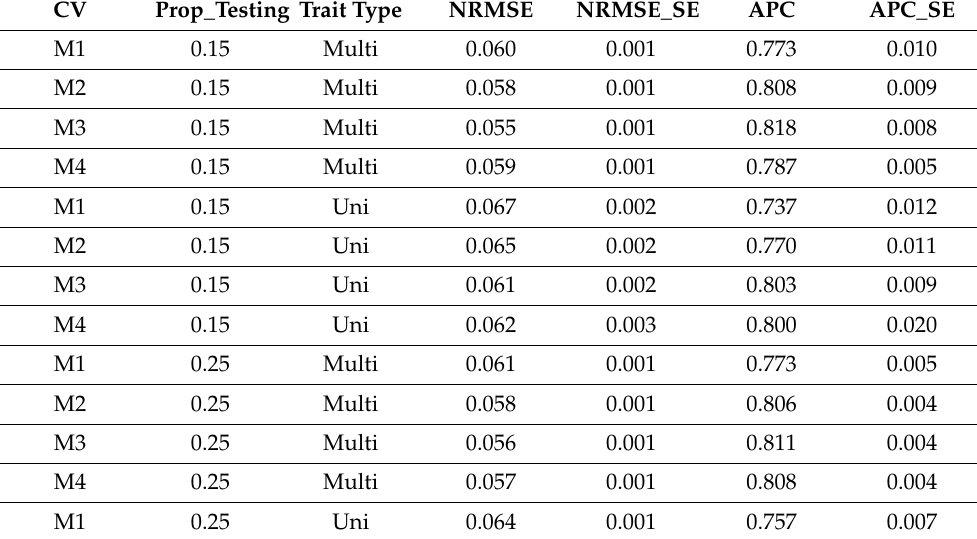
Table A3. Prediction performance across data sets in terms of normalized root mean square error (NRMSE) and Average Pearson’s correlation (APC) of the four sparse testing methods (CV) under the following proportion of testing (Prop_testing): 15% (0.15), 25% (0.25), 50% (0.5), 75% (0.75) and 85% (0.85). NRMSE_SE denotes the standard error of NRMSE, and APC_SE denotes the standard error of